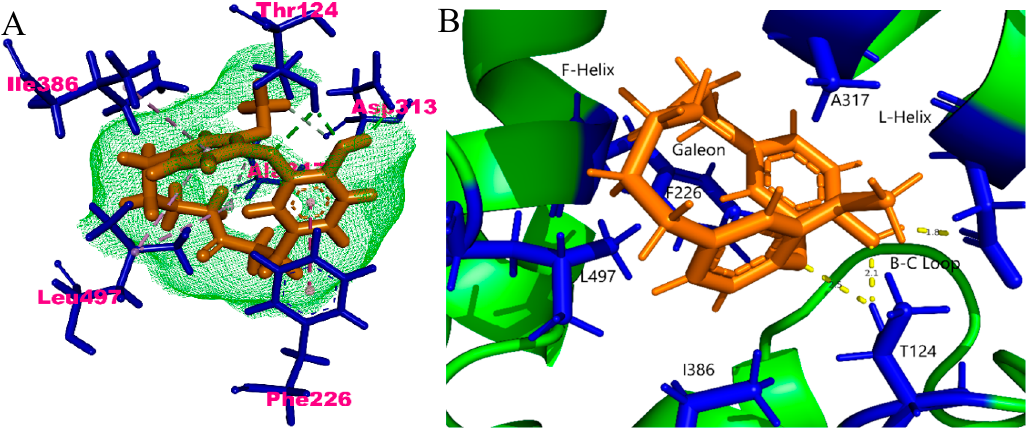
Figure 5. ( A ) 2D interaction mechanism of CYP1A2–galeon; ( B ) 3D interaction mechanism of CYP1A2–galeon.